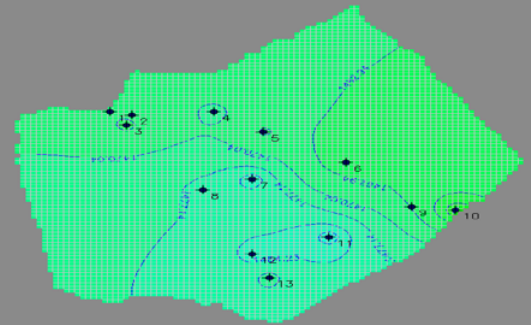
Figure 6. Hydraulic head of the Quar-Maharlu area Figure 7. The public boundaries of the head